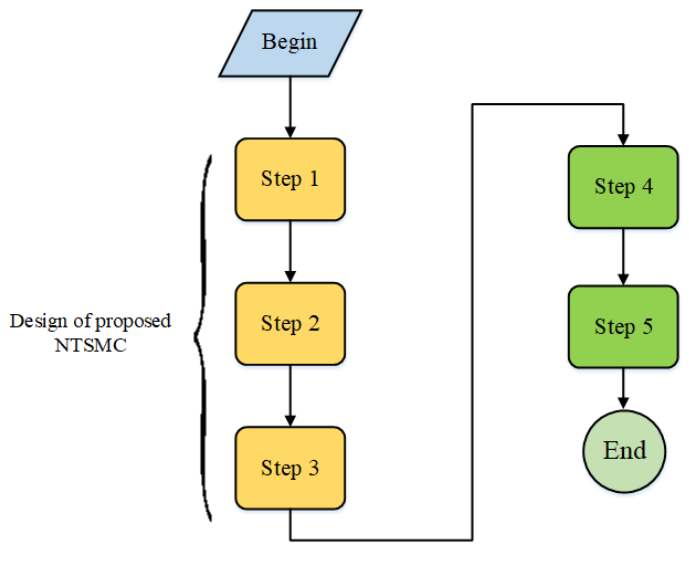
Figure 9. Flowchart of the proposed NTSM controller.